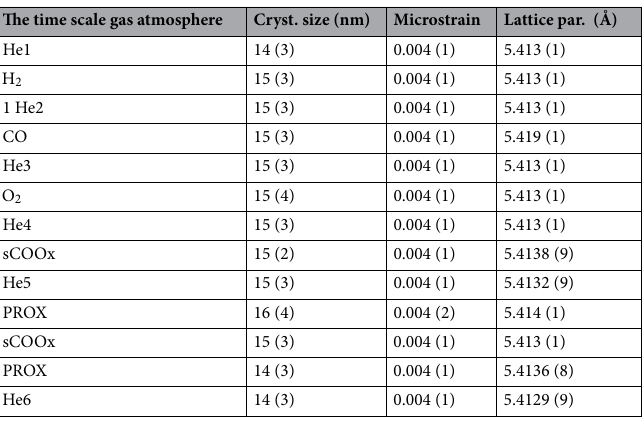
Table 1. Lattice parameters for CeO 2 blank experiment (Nelson–Riley extrapolation from 6 peaks). The last figure regression error given in